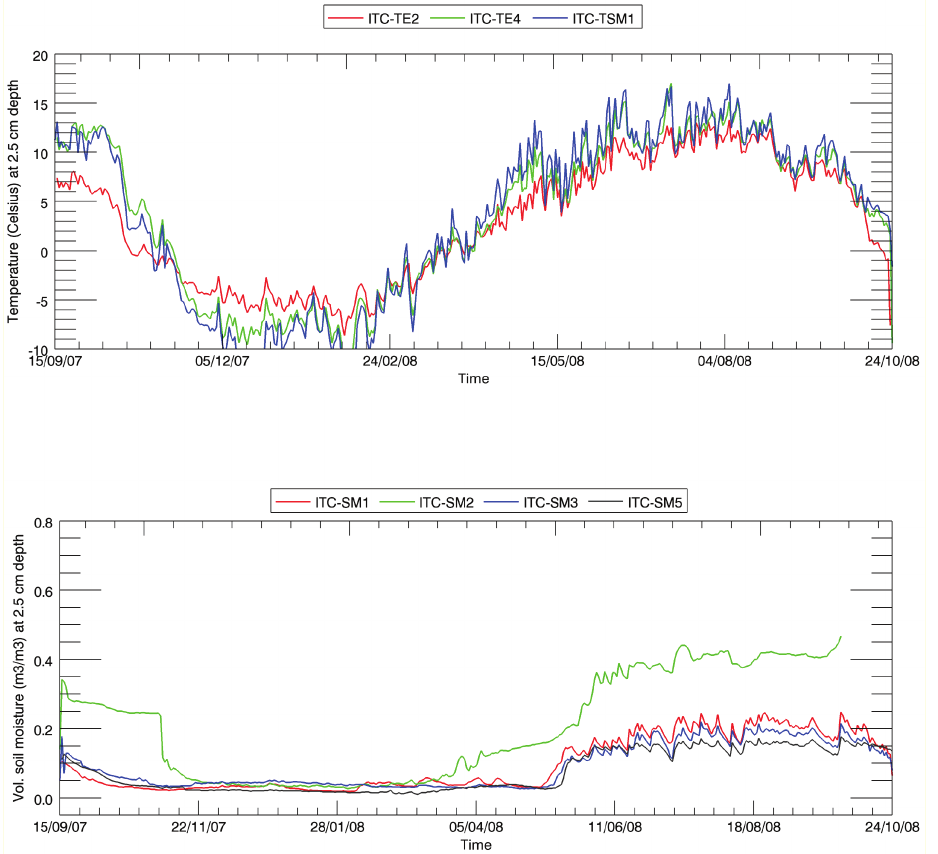
Fig. 2. Soil temperature (upper panel) and soil moisture (lower panel) measured at a 2.5cm depth in Naqu network area. Shown are records of individual data loggers from 15 September 2007 to 24 October 2998. South station (ITC-TE2 and ITC-SM2 for soil temperature and soil moisture respectively) is a wetland site. Naqu Station (ITC-SM5 for soil moisture), West Station (ITC-TSM1 for soil temperature), North Station (ITC-TE3, ITC-SM3 for soil temperature and soil moisture respectively), and East Station (ITC-TE4 for temperature only) are grassland sites with sparse grass coverage.